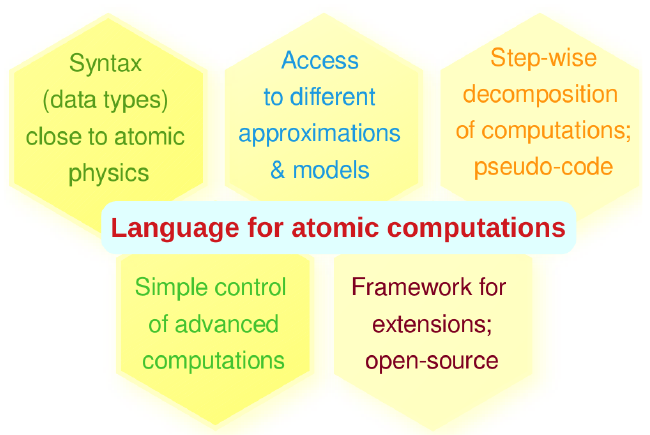
Figure 3. Requirements for establishing a domain-specific and descriptive atomic language as is implemented in J AC